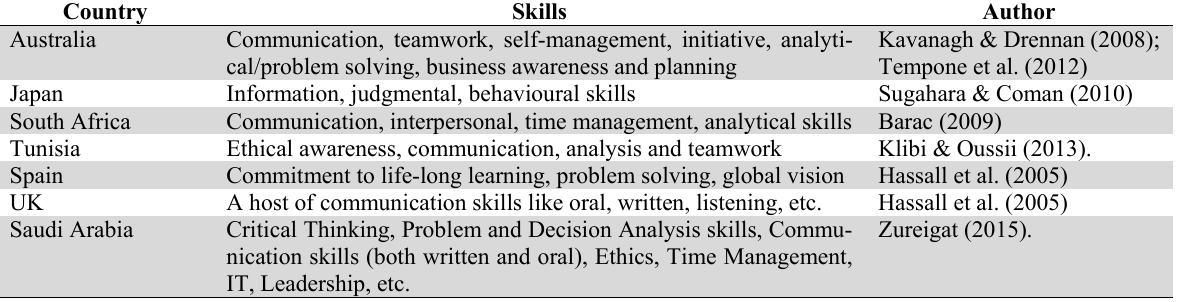
Employers perception of Accountant’s Generic skills across the globe Country Skills Author Australia Communication, teamwork, self-management, initiative,